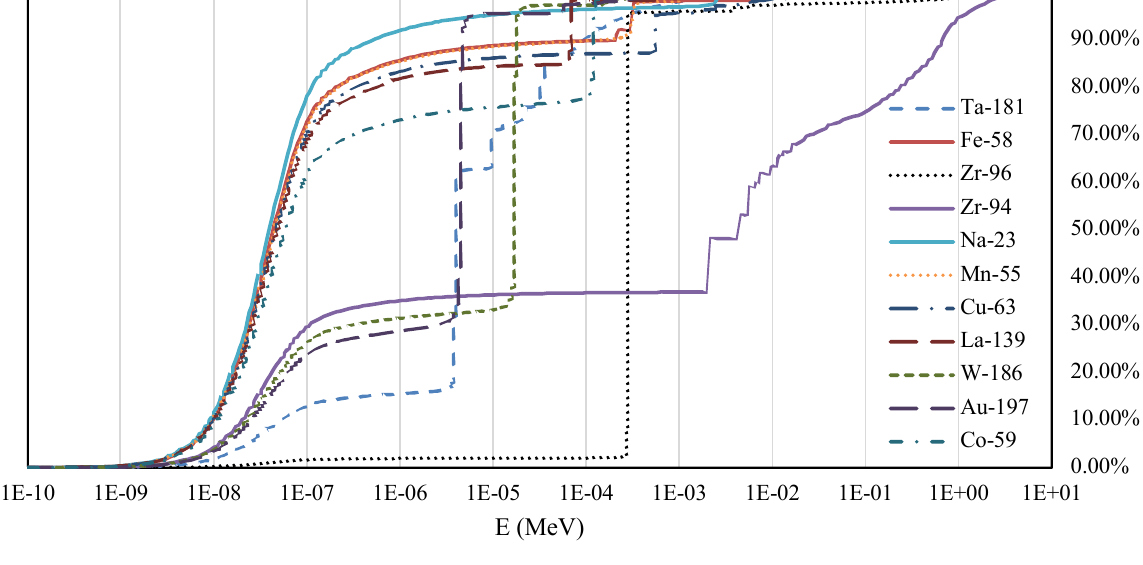
Figure 1. Cumulative reaction rates calculated in LR-0